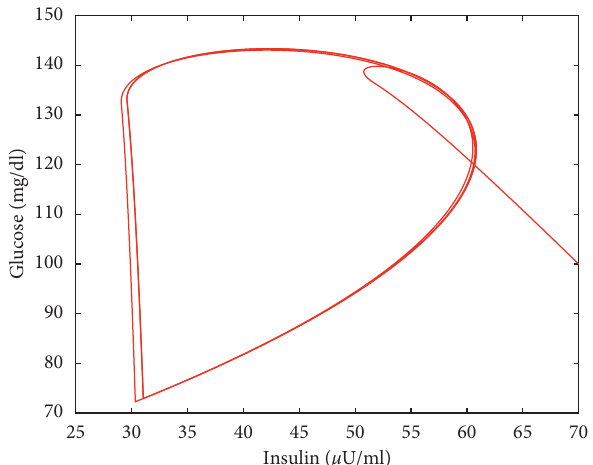
Figure 3: Phase diagram of system (8).